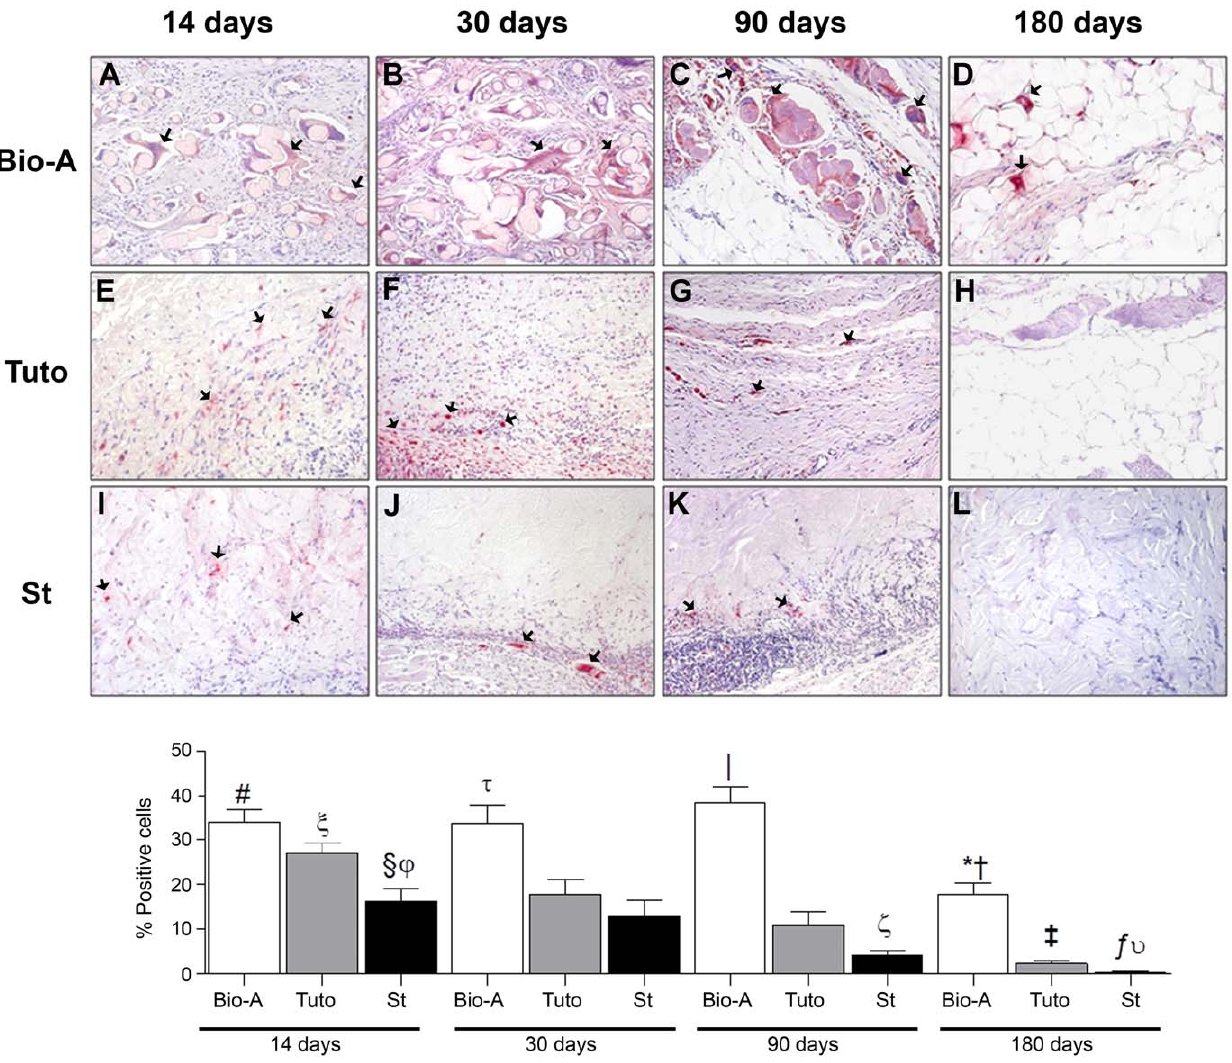
Figure 8. Foreign-body reaction of the different meshes. Immunohistochemical labeling of rabbit macrophages (red color, arrows) using the RAM-11 monoclonal antibody (200 6 ) (top panel): Bio-A (A–D), Tuto (E-H) and St (I–L). Percentage of positive cells for the RAM-11 antibody in the different prostheses after 14, 30, 90 and 180 days post-implantation (bottom panel). The results were expressed as the mean 6 SEM. A) Bio-A : *, vs. 14 days and 90 days ( P , 0.001) and 30 days ( P , 0.01); # , vs. St ( P , 0.001) at 14 days; t , vs. Tuto and St ( P , 0.01) at 30 days; |, vs. Tuto and St ( P , 0.001) at 90 days; { , Tuto and St ( P , 0.001) at 180 days post-implantion. B) Tuto : j , vs. 30 days ( P , 0.05) and 90 days ( P , 0.001); { , vs. 14 days and 30 days ( P , 0.001) and 90 days ( P , 0.01). C) St : 1 , vs. 90 days ( P , 0.001); e , vs. 14, 30 and 90 days ( P , 0.001); w , vs. Tuto ( P , 0.01) at 14 days; j , vs. Tuto ( P , 0.05) at 90 days; u , vs. Tuto ( P , 0.001) at 180 days post-implantation.